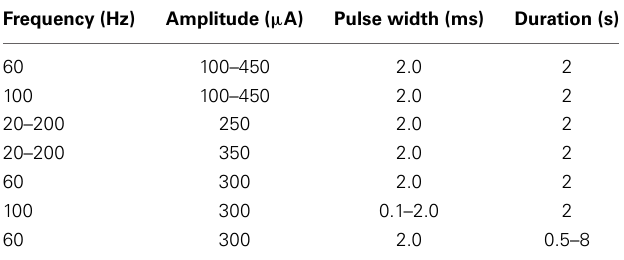
Table 1 | Stimulation